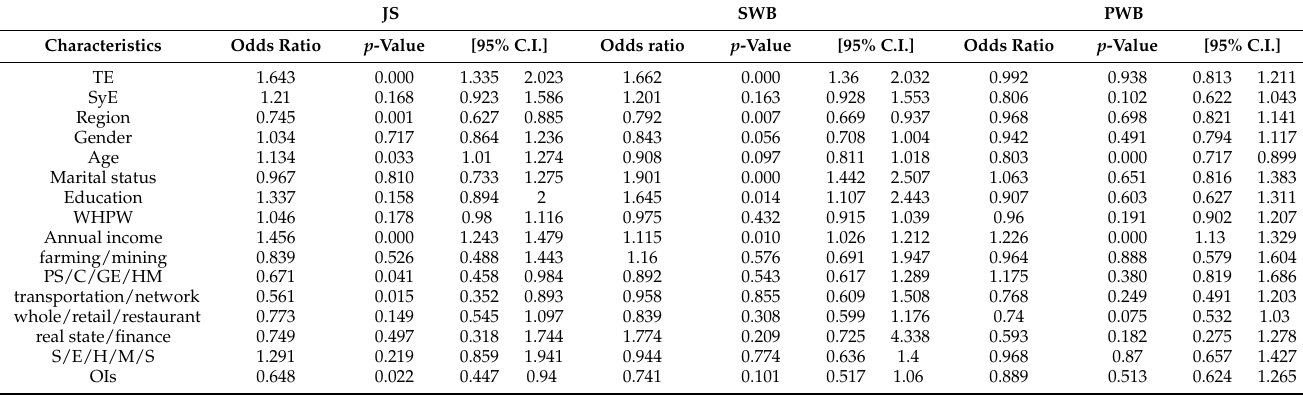
Table 8. Ordinal logistic regression of job-related wellbeing with different factors in subsample